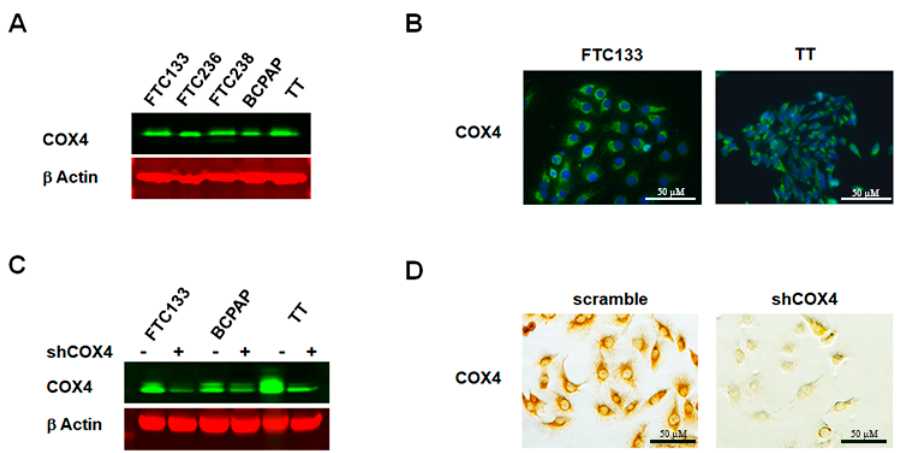
Figure 3. COX4 expression and efficiency of COX4 silencing in thyroid cancer cell lines. ( A ) Western blot analysis shows expression of COX4 in thyroid cancer cells with no significant differences between FTC-, PTC-, and MTC-derived cells. ( B ) Immunostaining with COX4 (green) and DAPI (blue) in FTC133 and TT cells demonstrates perinuclear expression of COX4. ( C ) Western blot using protein lysate of thyroid cancer cells transfected with scramble or COX4 specific shRNA demonstrates downregulation of COX4 in cells transfected with shCOX4. ( D ) Loss of COX4 immunostaining in FTC133 cells after transfection with shCOX4.